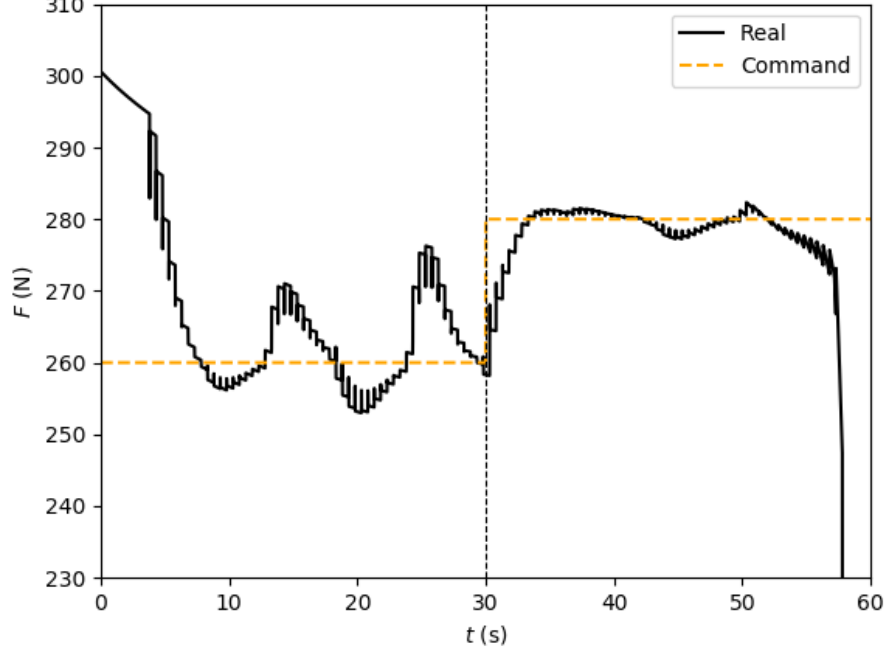
Figure 37. Thrust profile, feedback with downgraded regulation law, case 2, ds = 3 mm.